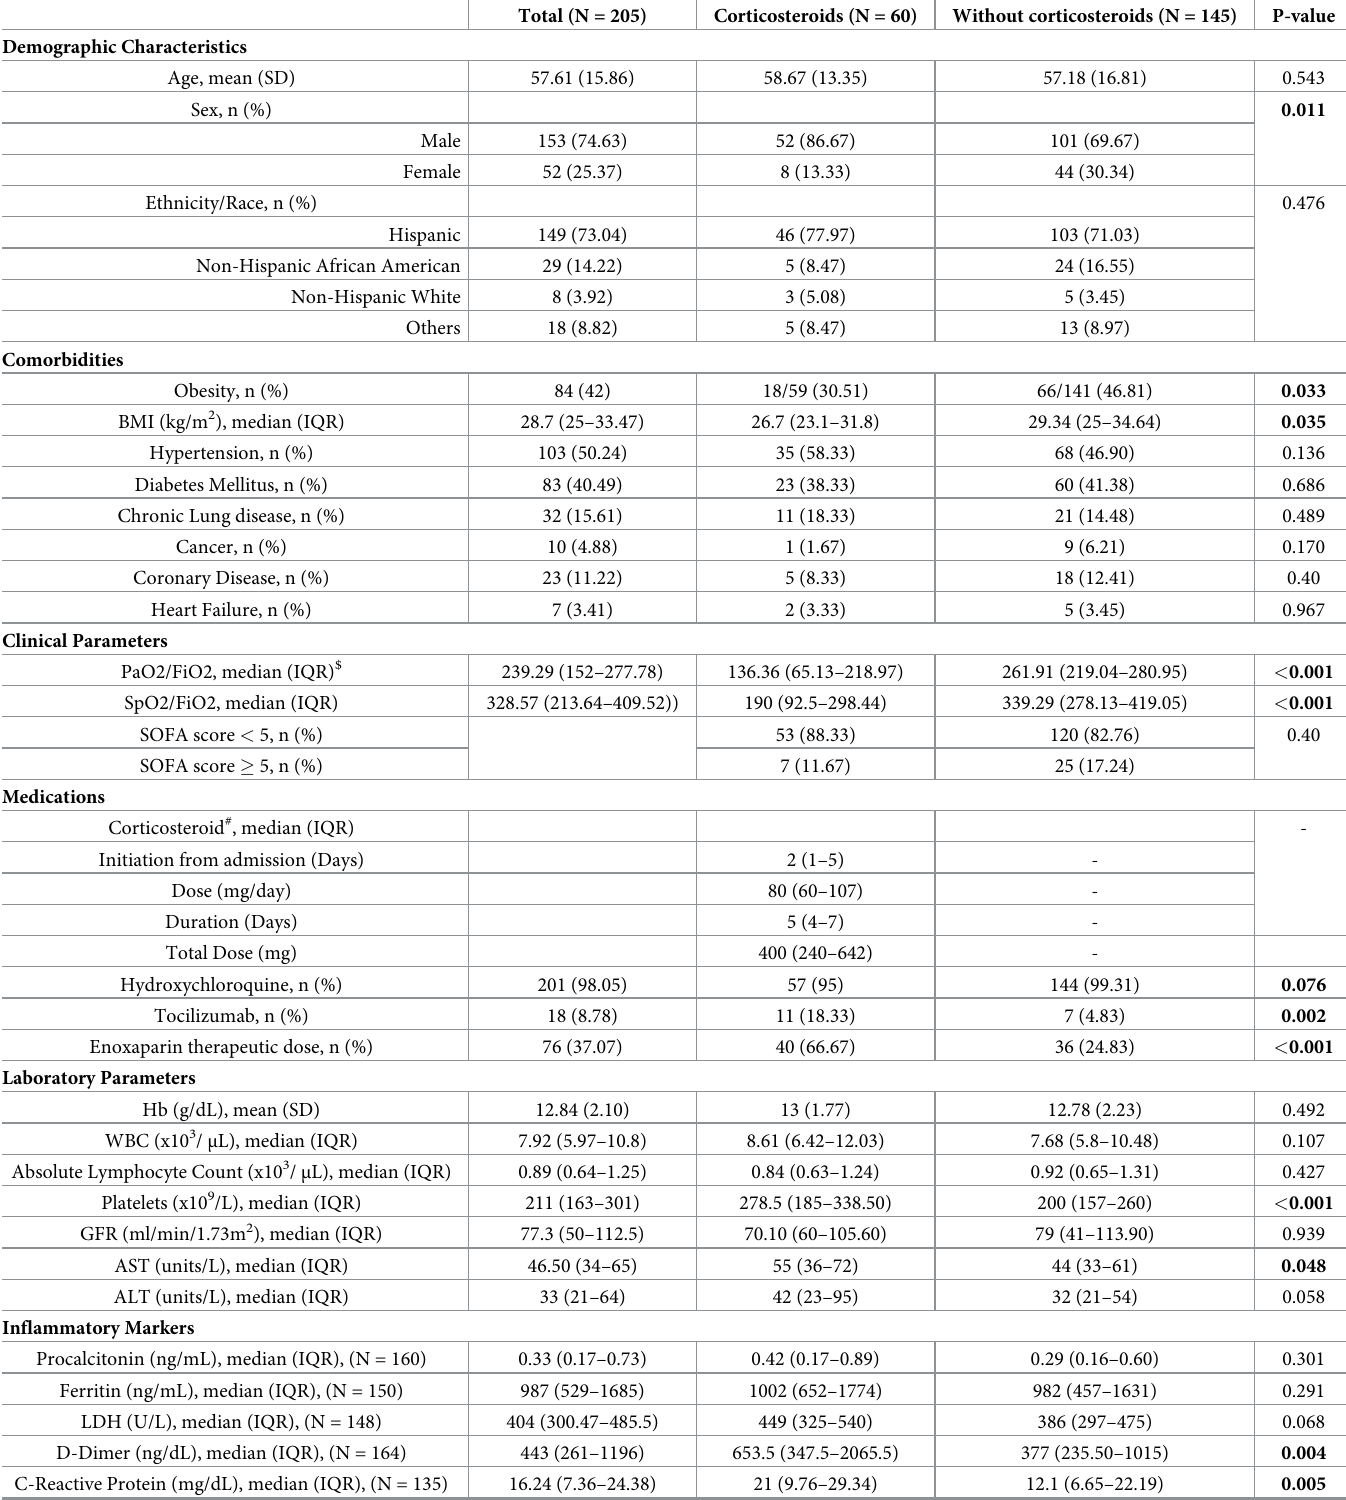
Table 1. Demographic, laboratory characteristics, and outcomes by